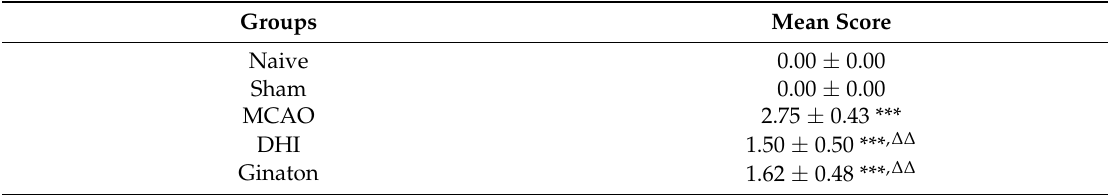
Table 1. The neurological deficit scores of groups from Figure 1A.